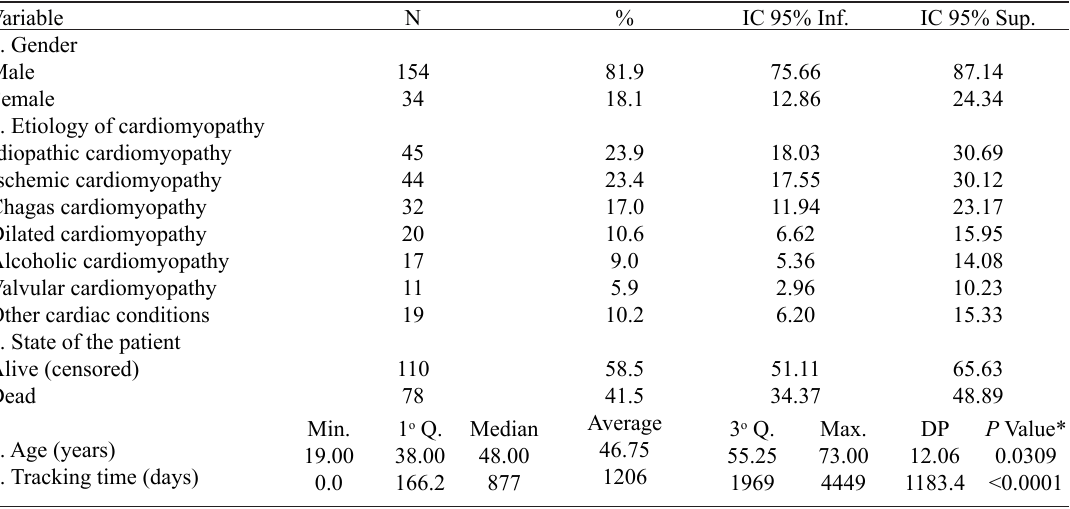
Table 1. Distribution of patients submitted to cardiac transplantation. Fortaleza, Ceará, Brazil. 2011 Variable